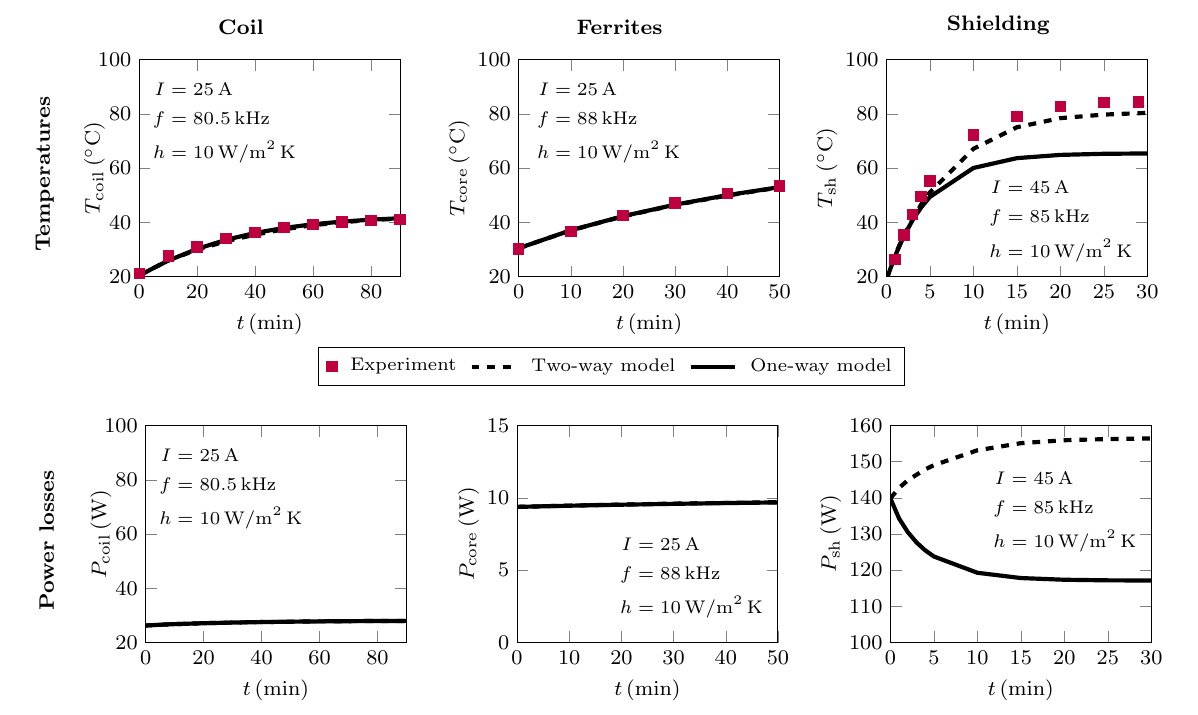
Figure 7. Component-level simulation and experimental validation of the electromagnetic–thermal simulation models’ transient